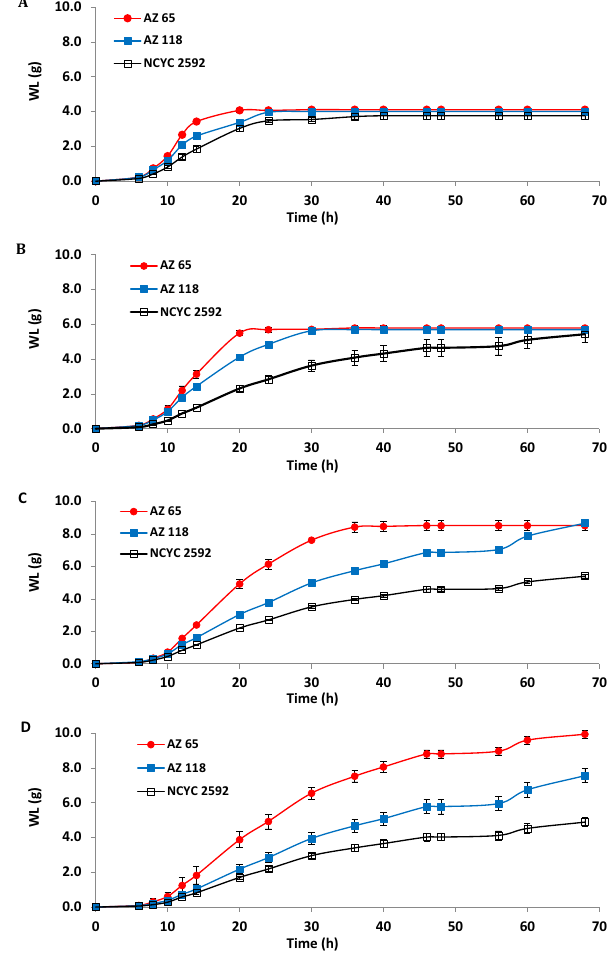
Figure 3. Fermentation performance of two marine yeast strains when exposed to osmotic stress using YPD media containing glucose concentrations (10, 15, 20, 25%) dissolved in seawater. ( A ) Glucose 10%, ( B ) glucose 15%, ( C ) glucose 20%, ( D ) glucose 25%. AZ65 & AZ118 are two maine S. cerevisiae strains. NCYC2592 is a terrestrial S. cerevisiae strain used as a reference for comparison. Weight loss as a result of CO 2 release from MFVs was measured during the fermentation at different time intervals to assess the fermentation rate of each yeast strain. The experimental error bars represent the standard deviation of the three